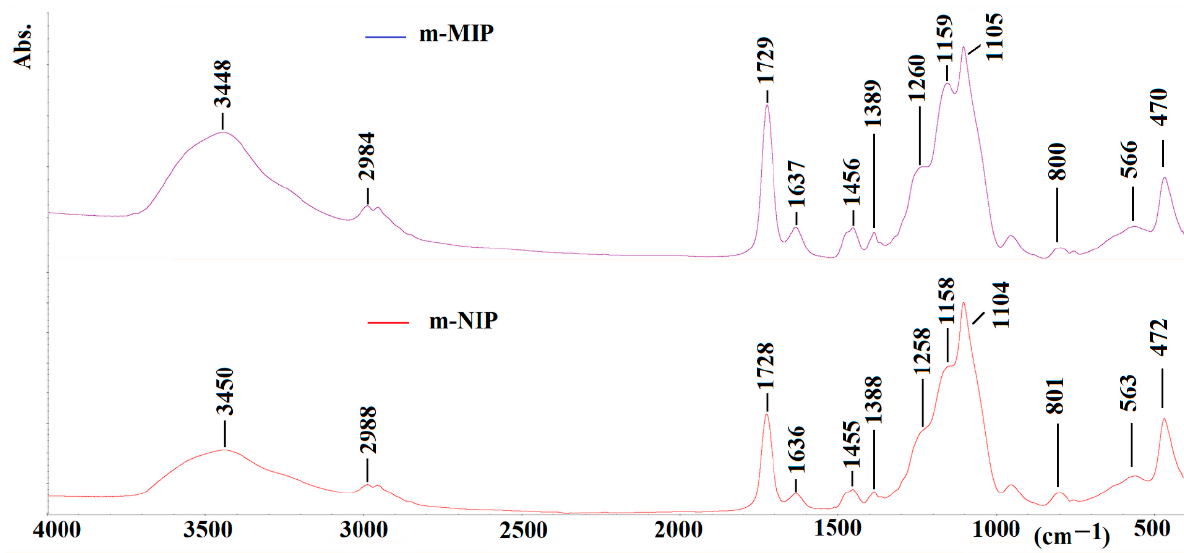
Figure 6. FTIR spectra of m-MIP (purple) and m-NIP (red). The characteristic vibration peaks derived from structural fragments of the poly- mer network can be seen. The assigning of peaks for m-MIP is as follow (value